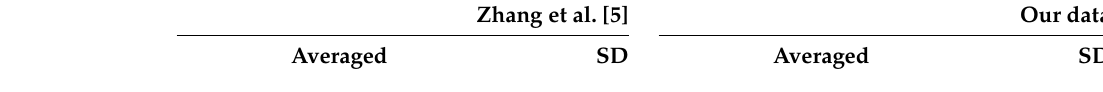
Table 3: FPKM expression data (averaged) from 2 projects on mouse. Genes Zhang et al. [5] Our data Averaged SD Averaged SD